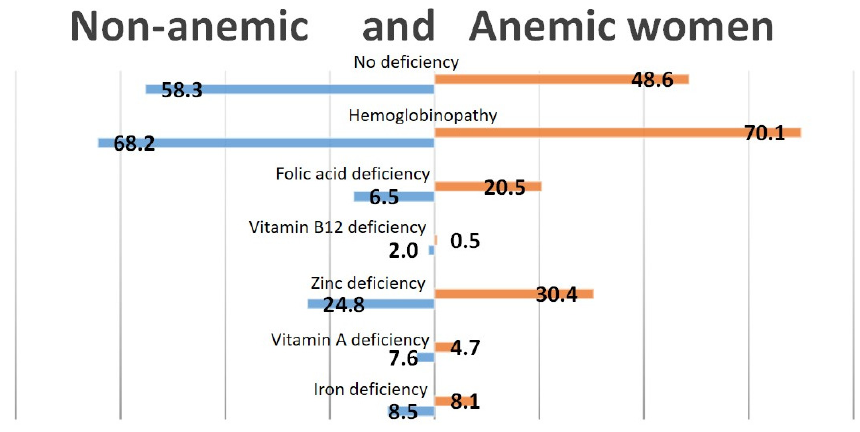
non-anemic children. children. children.